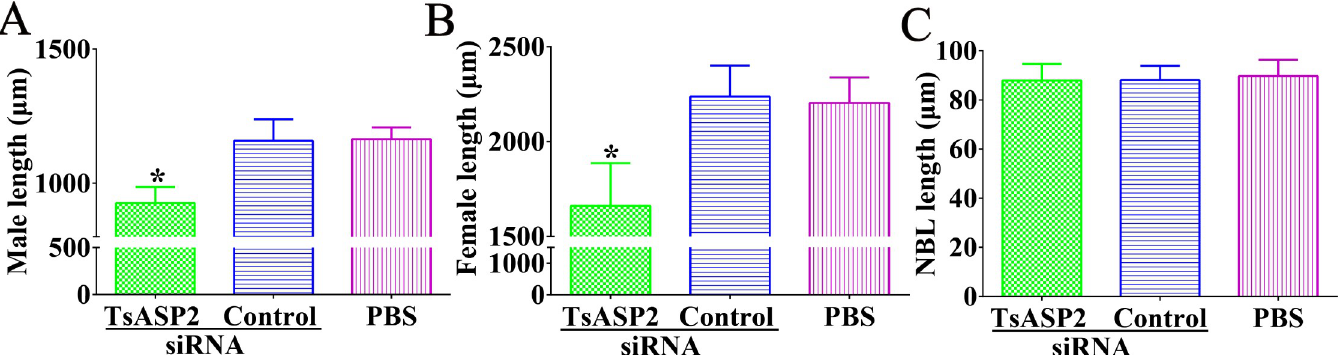
Fig 13. The lengths of different T . spiralis stage worms in mice infected with muscle larvae treated with TsASP2 siRNA. A: Male adults ; B: female adults ; C: NBL. Asterisks indicate a statistically significant difference compared with the control siRNA and PBS groups ( � P <